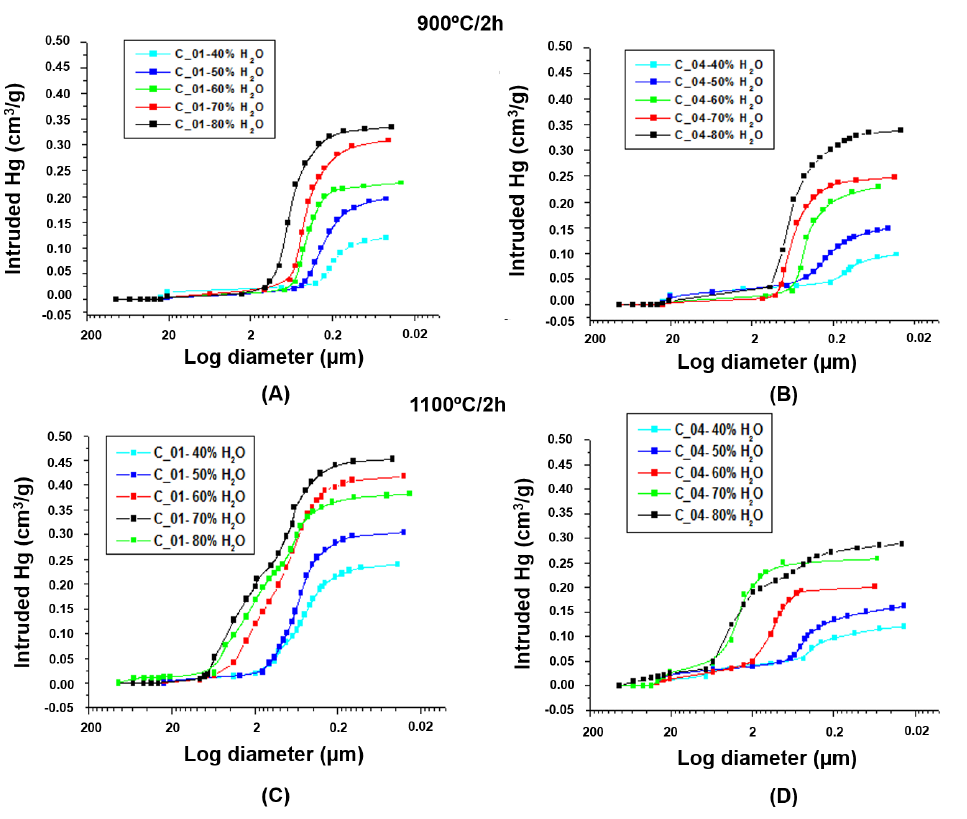
Figure 7. Effect of water content on the pore size distributions of compositions (A) and (B) containing MgO powders calcined at 900 ºC / 2 h and (C) and (D) containing MgO powders calcined at 1100 ºC / 2 h.